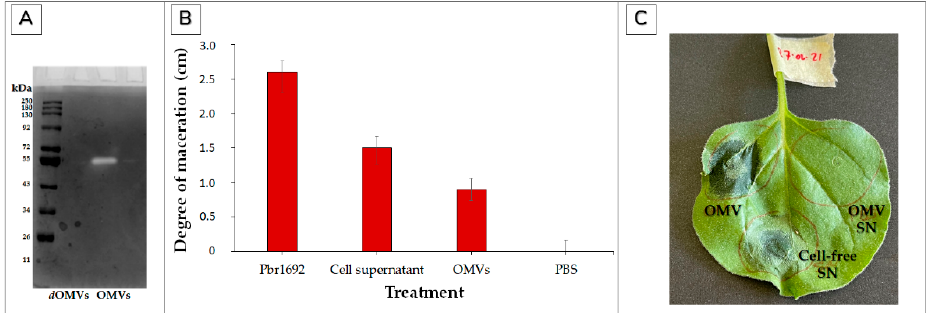
Figure 7. Virulence activities of Pbr1692 OMVs. ( A ) OMV protease activity. A 12% SDS PAGE zymogram gel shows Pbr1692 OMV digestion of gelatine via protease activity. Gelatinase digestion by the OMVs is demonstrated by the white band clearing zone corresponding to a ~55 kDa protein by visualization using Coomassie Brilliant blue staining. Denatured OMVs were used as a negative control. M = marker; dOMVs = denatured OMVs. ( B ) Soft rot of potato tubers by Pbr1692 OMVs .